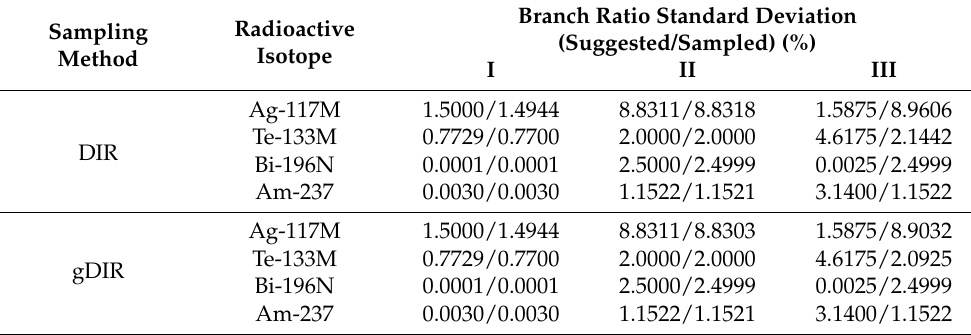
Figure 9. Comparison between suggested STDs in ENDF/B-VIII.0 and estimated STDs from gDIR sampling method. (Black “+”, red “.”, and blue “×” are decay branches I, II, and III, respectively; STD means standard deviation; Outliers are observed in the estimated branch ratio STD of branch III in Bi-196N, Ag-117M, Te-133M, and Am-237.). Table 2. Outliers of estimated STD in DIR and gDIR sampling.